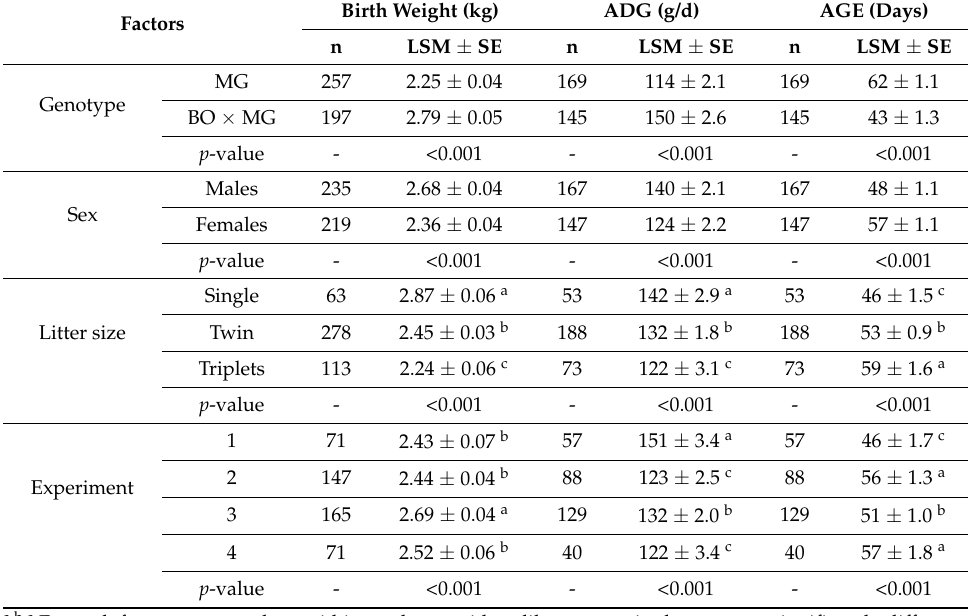
Table 6. Least Square Means (LSM ± SE) of the birth weight and average daily gain (ADG) and age (AGE) from birth to 9 kg live weight of kids according to the genotype (crossbred and purebred), sex, litter size and experiment. Crossbred kids were from Boer bucks × Murciano-Granadina goats (BO × MG). Purebred kids were Murciano-Granadina breed (MG).